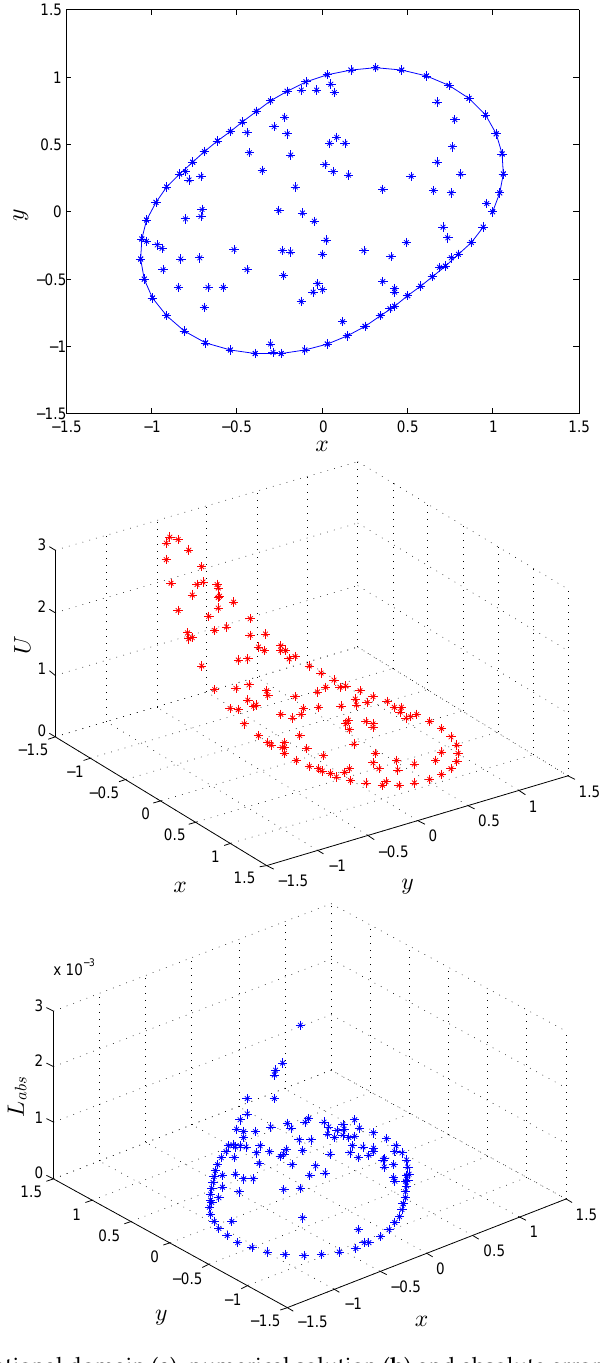
Figure 6. Computational domain ( a ), numerical solution ( b ) and absolute error ( c ) by using the EEM for Test Problem